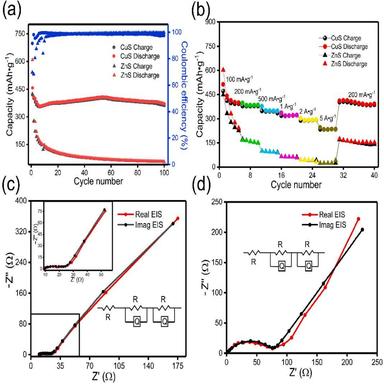
(a) Cyclic performance graph of CuS and ZnS electrodes at a current density of 100 mA g− 1 ; (b) Rate performance graph of CuS and ZnS electrodes; (c) Electrochemical impedance spectrum of CuS electrodes; (d) Electrochemical impedance spectrum of ZnS electrodes.